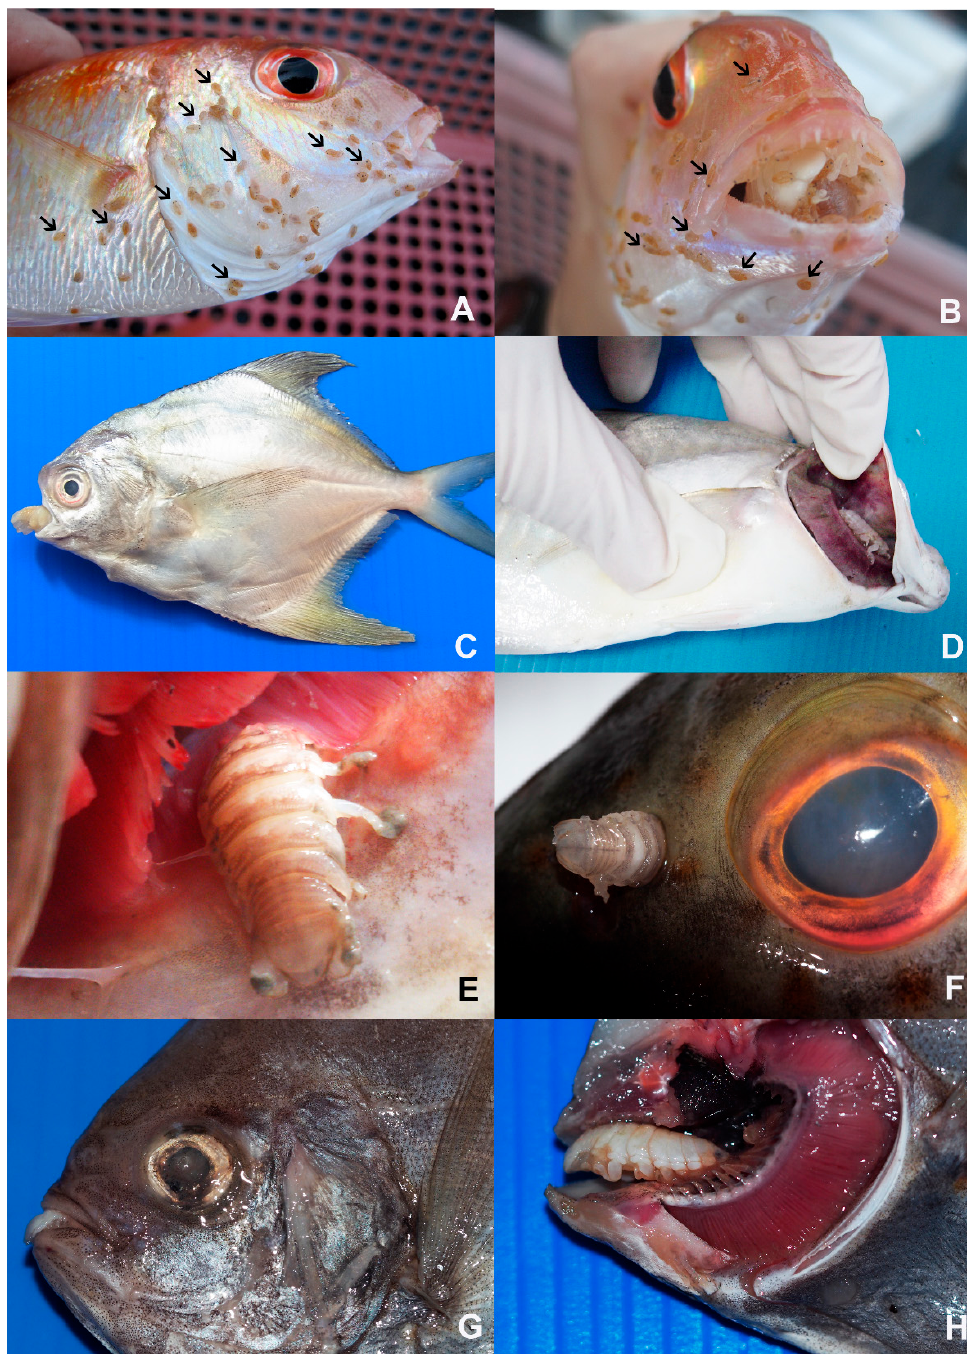
Figure 2. Various species of parasitic isopods attached to their fish host. ( A , B ) Cymothoa eremita in the buccal cavity of Nemipterus hexodon , many mancae (arrows) attached to same fish host. ( C ) Smenispa irregularis in the buccal cavity of Pampus argentius . ( D ) Smenispa irregularis in the gill chamber of Caranx hippos . ( E ) Argathona rhinoceros in the gill chamber of Epinephelus coioides . ( F ) Argathona rhinoceros in the nasal cavity of Epinephelus coioides . ( G , H ) Smenispa irregularis in the buccal cavity of Parastromateus niger , ( H ) after removal of the operculum).